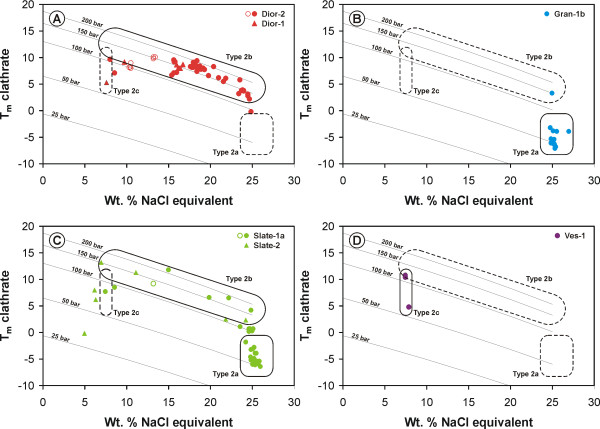
Diagrams showing the relationship between the final melting temperature of the clathrate and the salinity (uncorrected for the presence of clathrate) of type 2 fluid inclusions in rodingitized diorite (A; samples Dior-1, -2), rodingitized granite (B; sample Gran-1b), rodingitized slate (C; samples Slate-1b, -2), and in vesuvianite (D; sample Ves-1). Primary type 2 fluid inclusions form three distinct populations: 1) Low density type 2a fluid inclusions characterized by high salinity and low final clathrate melting temperatures, 2) high density type 2b fluid inclusions showing a wide range of salinities and elevated final clathrate melting temperatures, and 3) low density and low salinity type 2c fluid inclusions found in vesuvianite. Also shown on the diagrams are isobars at pressures of 25, 50, 100, 150 and 200 bar for the system CH4-NaCl-H2O calculated using program CURVES [30]. Filled symbols represent data for primary fluid inclusions and open symbols represent data for secondary fluid inclusions. Refer to the text for a detailed discussion.